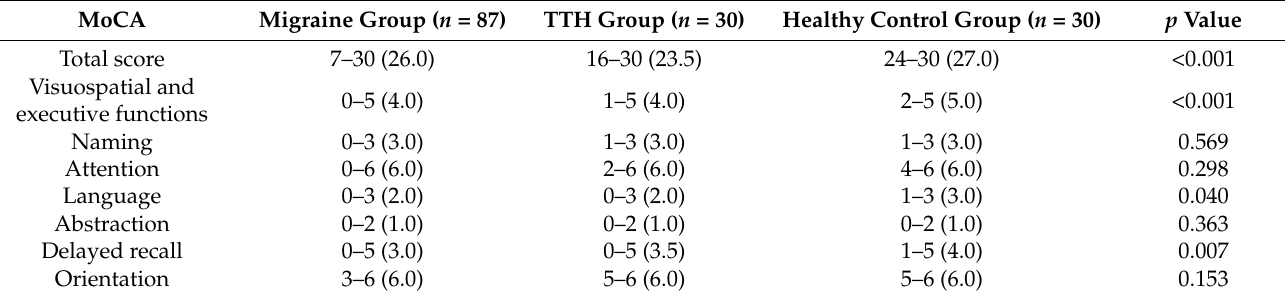
Table 3. Scores of cognitive function in the migraine, TTH, and healthy control